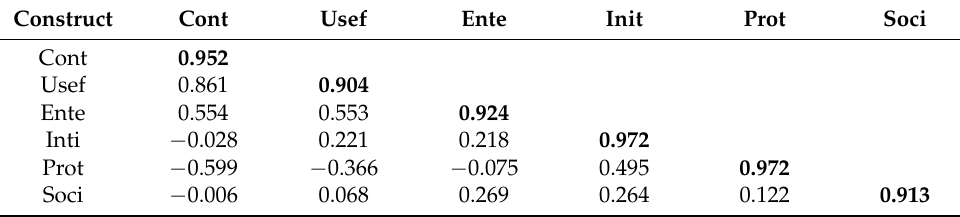
Table 4. Correlations among constructs and the square root of the AVE.